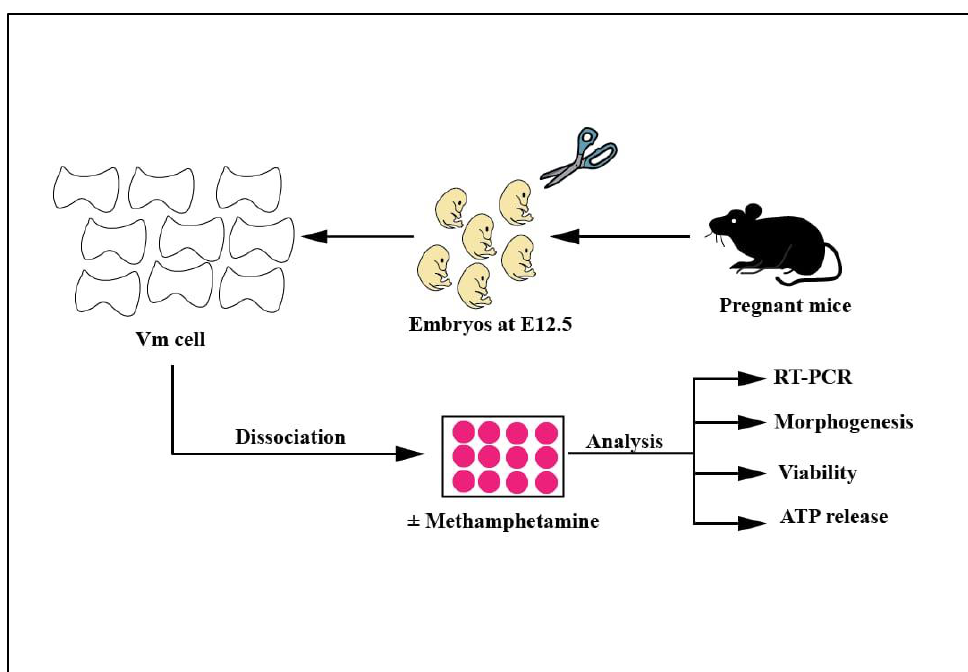
Figure 1. Scheme of the experimental design.